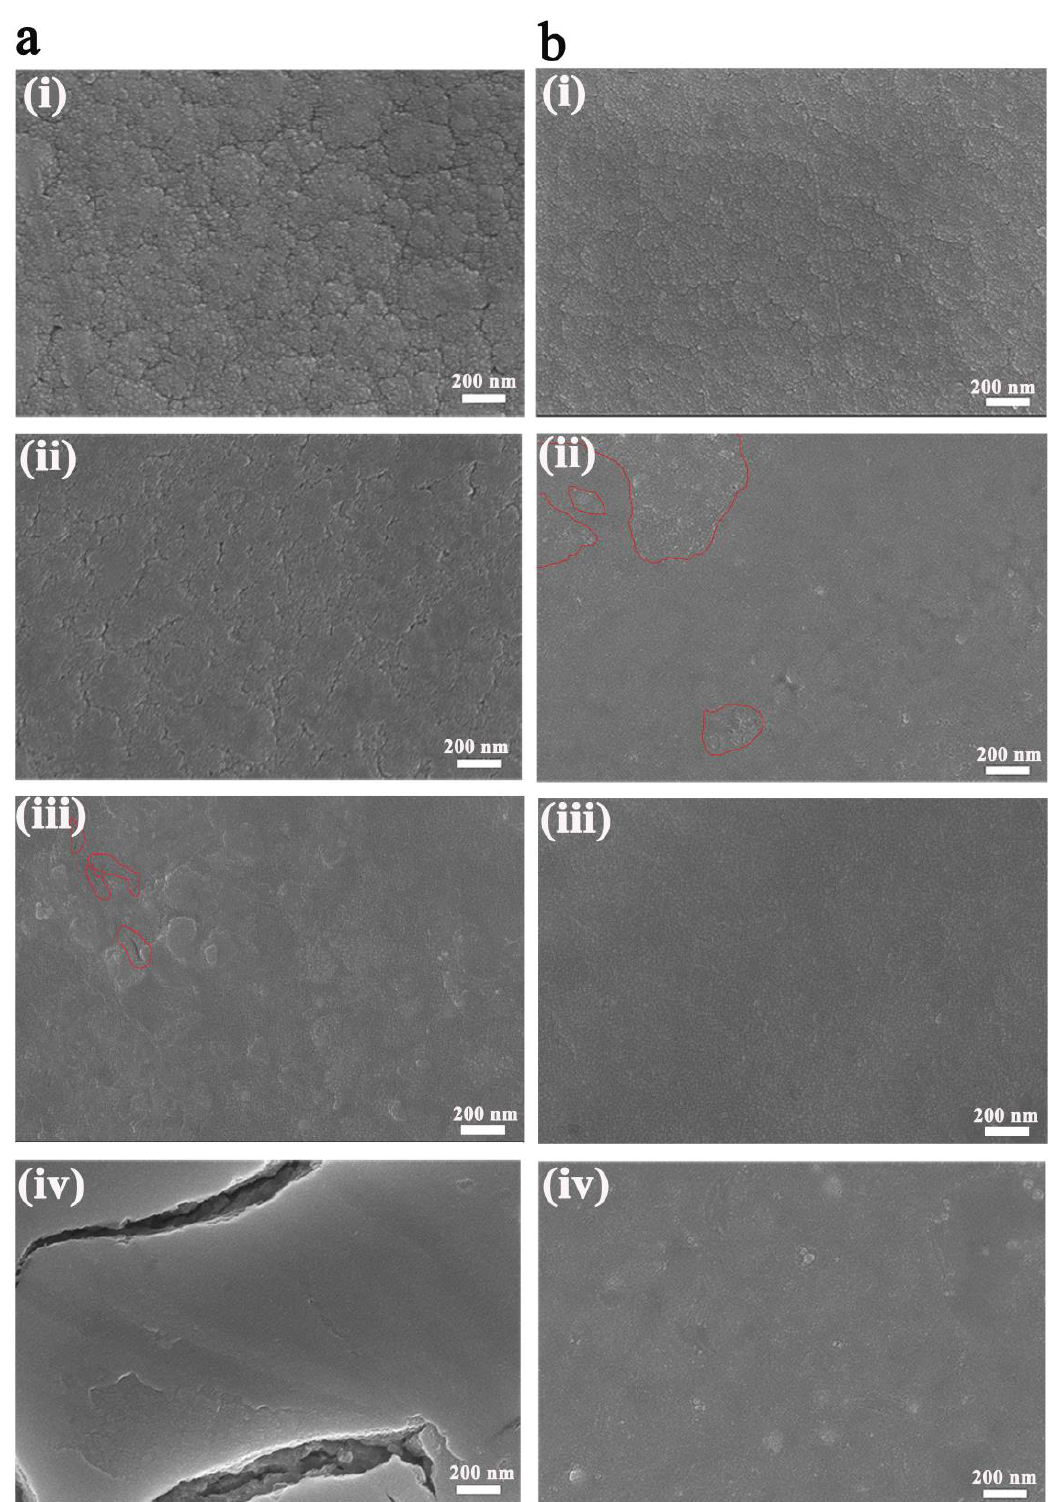
Figure 4. SEM morphology evolution of the WO 3 films in bleached state during 5000 CV cycles prepared at the sputtering power of 50 W ( a ) and 100 W ( b ), after 3 cycles ( ai , bi ), after 1000 cycles ( aii , bii ), after 3000 cycles ( aiii , biii ), and after 5000 cycles ( aiv , biv ), where red line circles indicate the micro-cracks in the 50 W-deposited film and partly loose areas in the 100 W-deposited